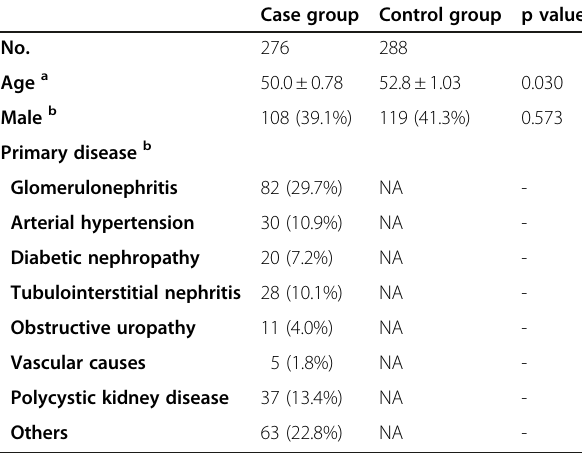
Table 1 Clinical characteristics of patients with